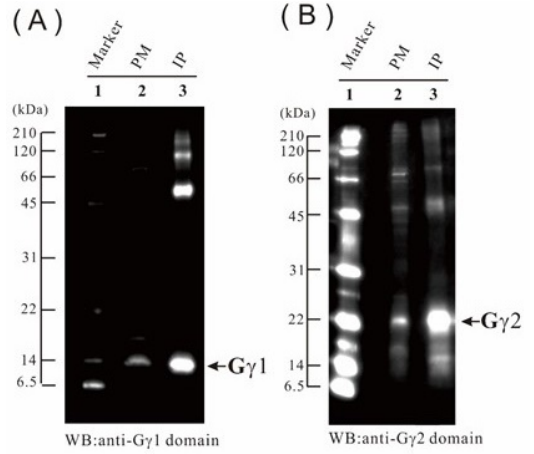
Figure 8. IP of the G γ 1 and G γ 2 subunits in the etiolated leaf. ( A ) IP of G γ 1 from the solubilized plasma membrane protein. Lane 1, molecular weight markers; lane 2, 10 μ g of plasma membrane protein; lane 3, IP product of solubilized plasma membrane proteins. Immunoblot analysis was carried out using an anti-G γ 1 antibody. ( B ) IP of G γ 2 from solubilized plasma membrane protein. Lane 1, molecular weight markers; lane 2, 10 μ g of plasma membrane protein; lane 3, IP product of solubilized plasma membrane proteins. Immunoblot analysis was carried out using the anti-G γ 2 antibody. ( A ) MGSSCSR 1 SHSLSEAETTK NAKSADIDRR 2 ILQETK AEQHIHK 3 LLLLGAGE SGK STIFKQIK 4 LLFQTGFDEAELR SYTSVIHANVYQTIK 5 ILYEGAK 6 EL SQVESDSSK 7 YVISPDNQEIGEK 8 LSDIDGR LDYPLLNKELVLDVKR 9 LWQD PAIQETYLR GSILQLPDCAQYFMENLDRLAEAGYVPTKEDVLYARVR 10 TNG VVQIQFSPVGENK RGGEVYR 11 LYDVGGQR NERRKWIHLFEGVNAVIFCAA ISEYDQMLFEDETKNRMMETK 12 ELFDWVLK QRCFEK 13 TSFILFLNK FDIFEKKIQK 14 VPLSVCEWFK 15 DYQPIAPGK QEVEHAYEFVKKKFEELYFQ SSKPDRVDRVFKIYRTTALDQKLVKKTFKLIDESMRRSREGT* ( B ) MASVAELKEK 1 HAAATASVNSLR ERLRQRRQMLLDTDVERYSRTQGR 2 TPVSFNPTDLVCCR TLQGHSGK 3 VYSLDWTPEK 4 NWIVSASQDGR 5 LIVWNALTSQK THAIKLHCPWVMTCAFAPNGQSVACGGLDSACSIFNLNS QADRDGNIPVSRILTGHK 6 GYVSSCQYVPDQETR 7 LITSSGDQTCVLWDV TTGQR ISIFGGEFPSGHTADVLSLSINSSNSNMFVSGSCDATVR 8 LWDIR IA SRAVR 9 TYHGHEGDINSVK FFPDGQR 10 FGTGSDDGTCR LFDVR 11 TGHQ LQVYSR EPDRNDNELPTVTSIAFSISGRLLFAGYSNGDCYVWDTLLAEVVL NLGNLQNSHEGR 12 ISCLGLSSDGSALCTGSWDK NLKIWAFSGHRKIV* ( C ) MQAGGGGDAGDTRGRHR 1 I QAELK KLEQEAR 2 FLEEELEELDK TDK 3 VSAALQELMVTAESK 4 ADPLLPVTTGPACQSWDR 5 WFEGPQDLR RCKCWFL* ( D ) MR 1 GEANGEEEQQPPR R 2 NHLRDDAEEEEEVER R 3 AARPVSGQQQQQ QR 4 RRPTDVGGGAAMR 5 SVGYVGK HR 6 LSAAIAR LDQELQSLQDELN ELETMEPASAACQGVITSTEGK 7 SDPLLPVTIGPENASWER WFQRVRSSCS NK 8 WWASK GSDFP* Figure 9. LC-MS/MS analysis of the G α , G β , G γ 1, and G γ 2 subunits in rice. ( A ) Fifteen peptides ( p < 0.05) produced from trypsin-digested G α in the plasma membrane fraction are numbered and underlined in the full-length G α amino acid sequence. These peptides are listed in Table S11A. ( B ) Twelve peptides ( p < 0.05) produced from trypsin-digested G β in the plasma membrane fraction are numbered and underlined in the full-length G β amino acid sequence. These peptides are listed in Table S11B. ( C ) Five peptides ( p < 0.05) produced from trypsin-digested G γ 1 in the IP products are numbered and underlined in the full-length G γ 1 amino acid sequence. These peptides are listed in Table S11C. ( D ) Eight peptides ( p < 0.05) produced from trypsin-digested G γ 2 in the IP products are numbered and underlined in the full-length G γ 2 amino acid sequences. These peptides are listed in Table S11D.